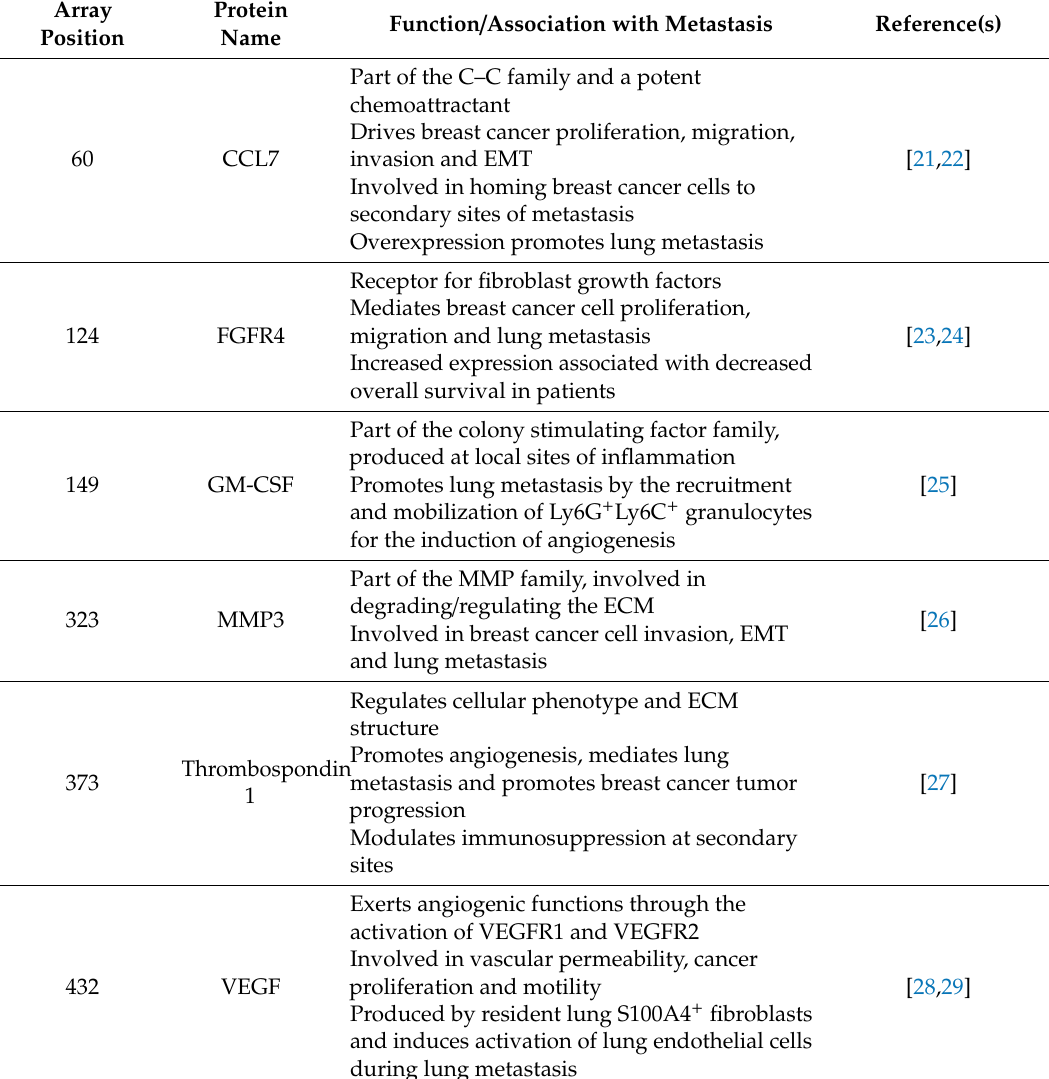
Table 1. Metastasis-associated proteins unique to lung-conditioned media (LCM) generated from the lungs of mice bearing triple-negative SUM159 primary tumors ( n =